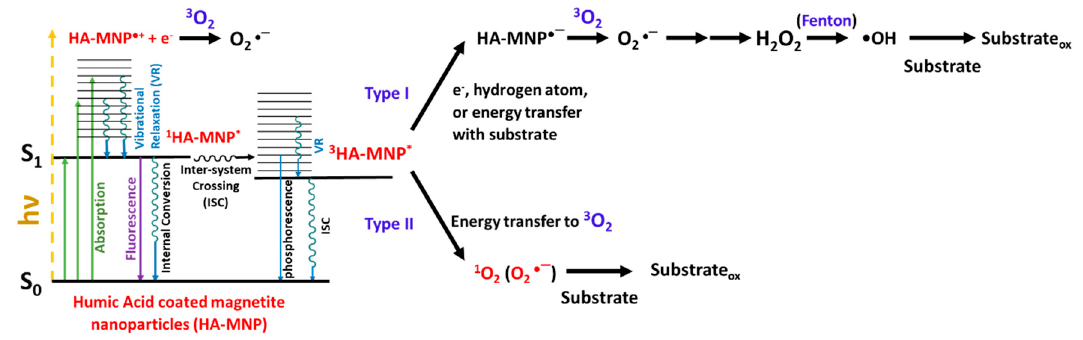
Figure 1. Photogeneration of di ff erent HA-MNP excited states and ROS via energy or electron transfer processes.